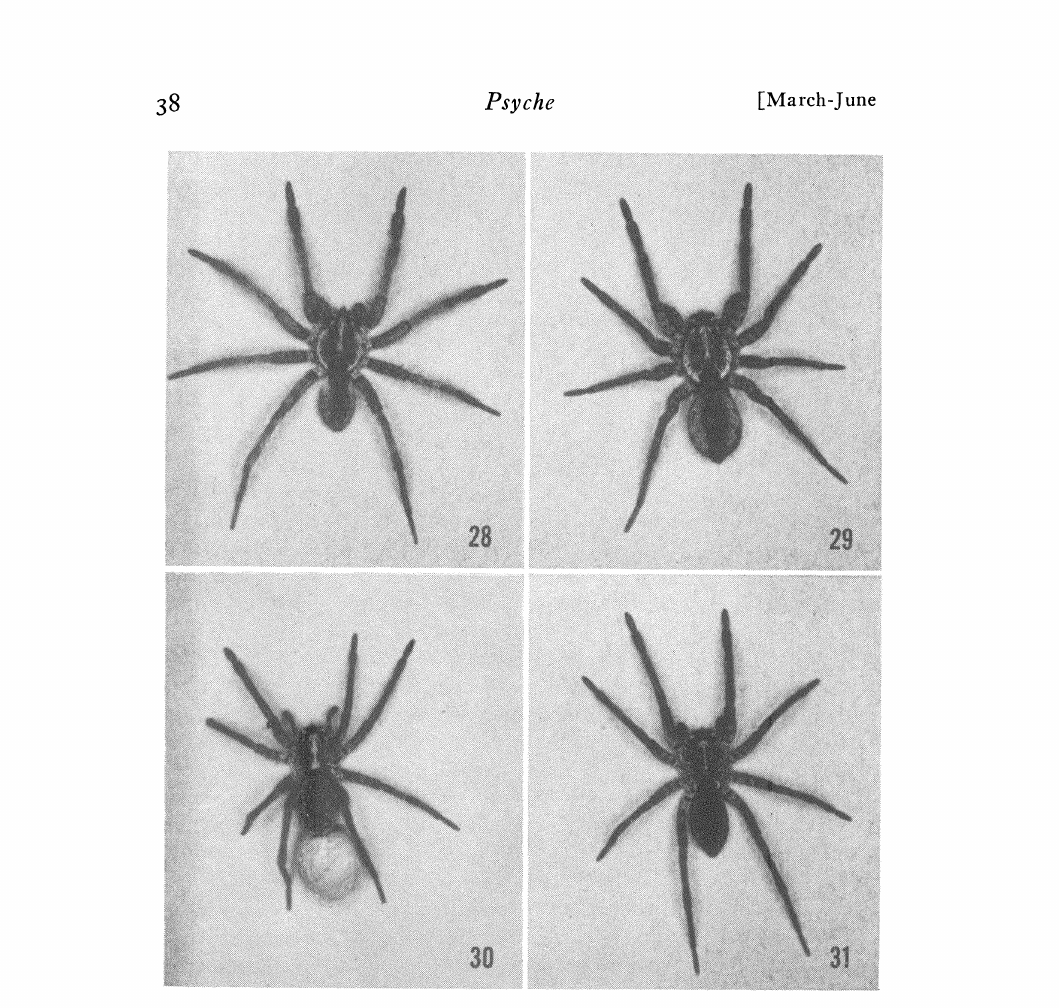
Figs. 28-30. Sosippus mimus Chamberlin, from Fountainbleau St. Pk., near Mandeville, St. Tammany Par., Louisiana, 17-18 June 198. 28. Male. 29. Female. 30. Female with egg case. Fig. 31. Female of Sosippus mimus Chamberlin, from Magnolia St. Pk. near Biloxi, Jackson Co., Mississippi, 18 June